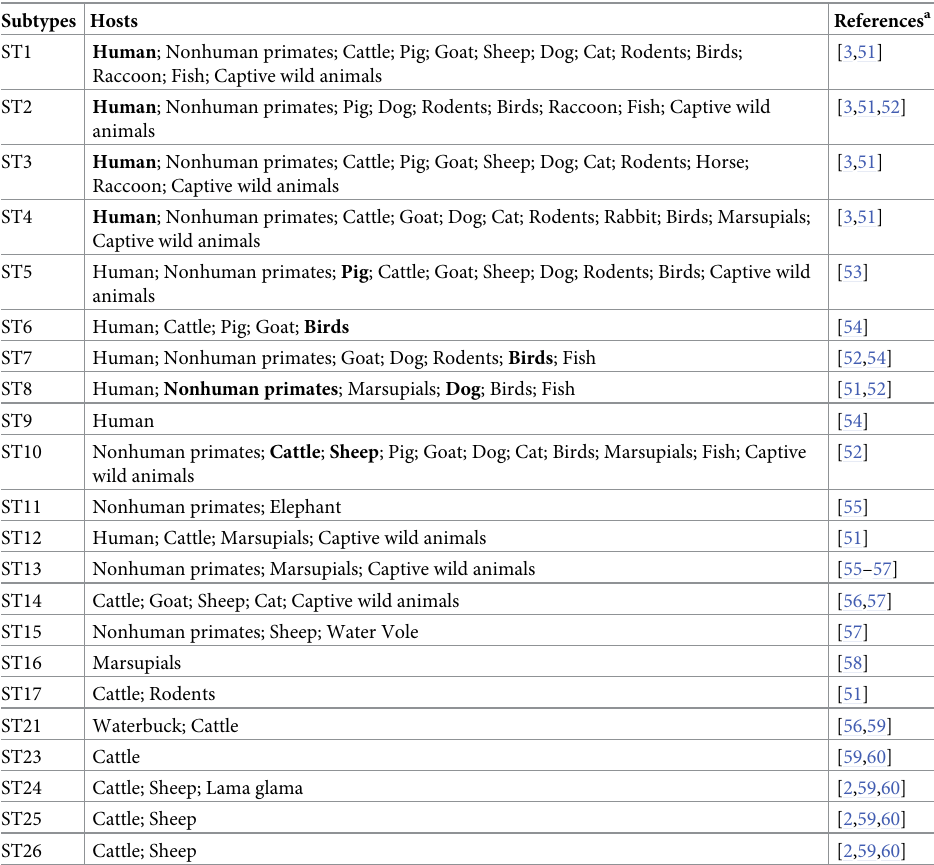
Table 2. The known hosts for various subtypes of Blastocystis